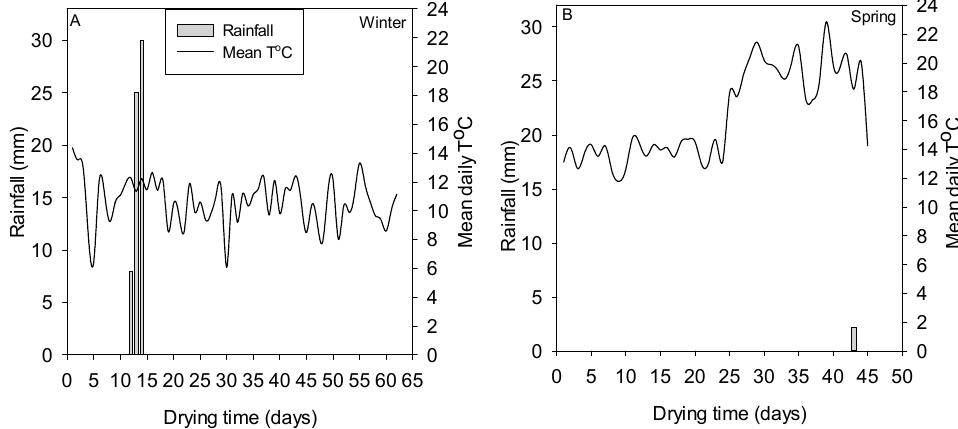
Figure 1. Weather conditions in winter and spring during sludge drying.